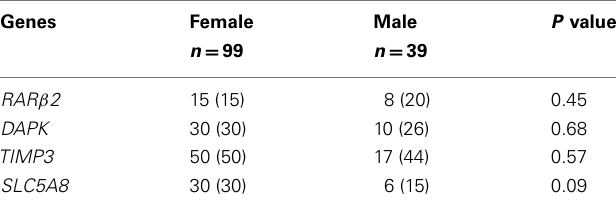
Table 2 | Gender distribution of methylation-positive patients for the indicated genes [ n (%)] (% = n / N